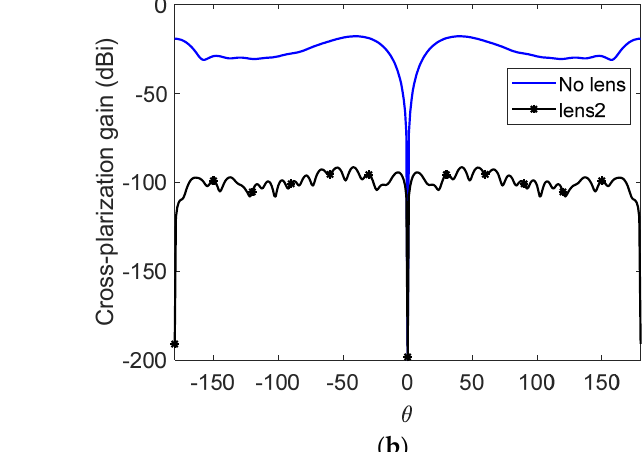
Figure 5. ( a ) The reflected scattering parameter and ( b ) cross ‐ polarization gain.